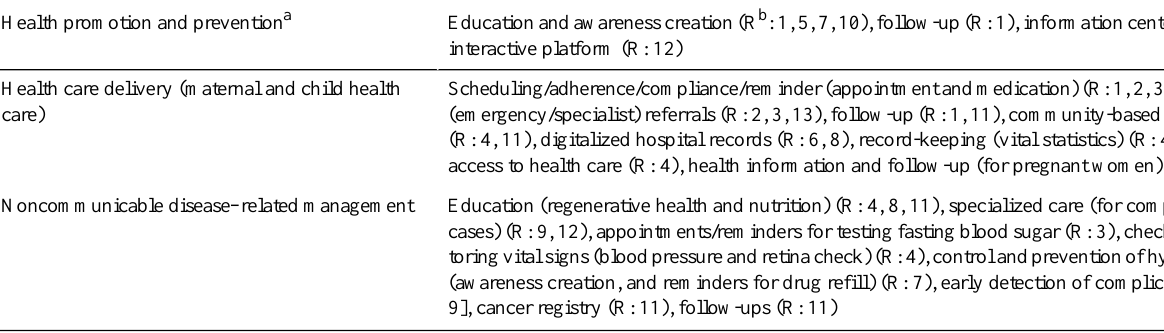
Table 2. Identified beneficial applications of mobile health interventions. Education and awareness creation (R b : 1, 5, 7, 10), follow-up (R: 1), information centers (R: 11), 12)Health promotion and prevention a interactive platform (R: Scheduling/adherence/compliance/reminder (appointment and medication) (R: 1, 2, 3, 7, 11, 12), (emergency/specialist) referrals (R: 2, 3, 13), follow-up (R: 1, 11), community-based health care (R: 4, 11), digitalized hospital records (R: 6, 8), record-keeping (vital statistics) (R: 4), creating access to health care (R: 4), health information and follow-up (for pregnant women)